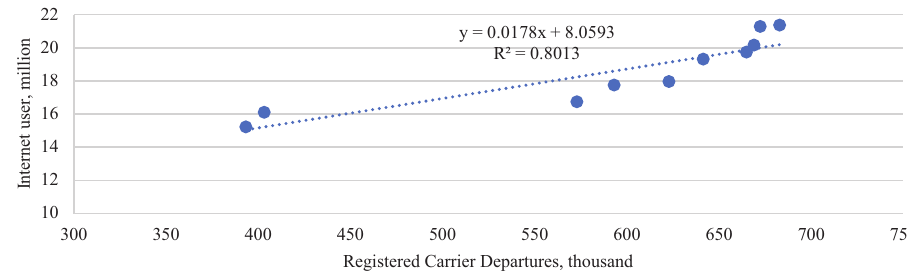
Figure 8. Regression result of registered carrier departures in Australia from 2008 to